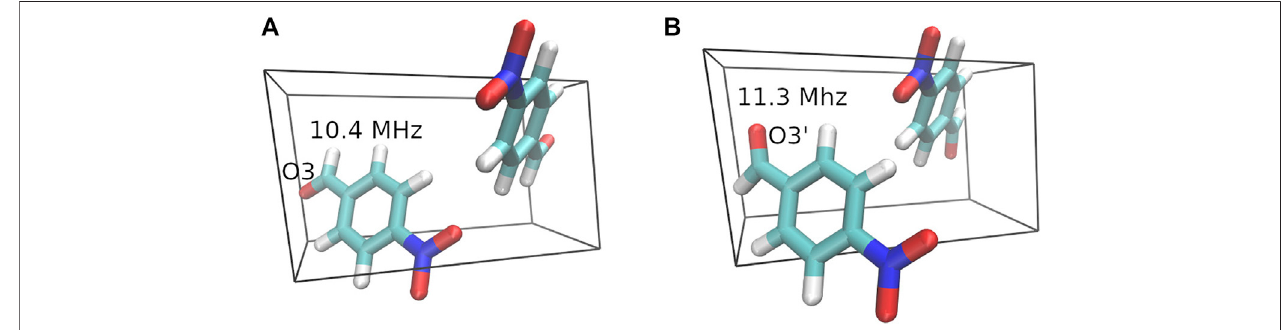
FIGURE 5 | Crystal structures for the two 4-Nitrobenzaldehyde geometries. The dominant crystal structure (A) with a 90% occupancy is shown on the left and structure (B) with a 10% occupancy is shown on the right. The 17 O C q predictions obtained from GIPAW + MC calculations with a PBE0/6-311+G (2d,p) molecular correction are included in the fi